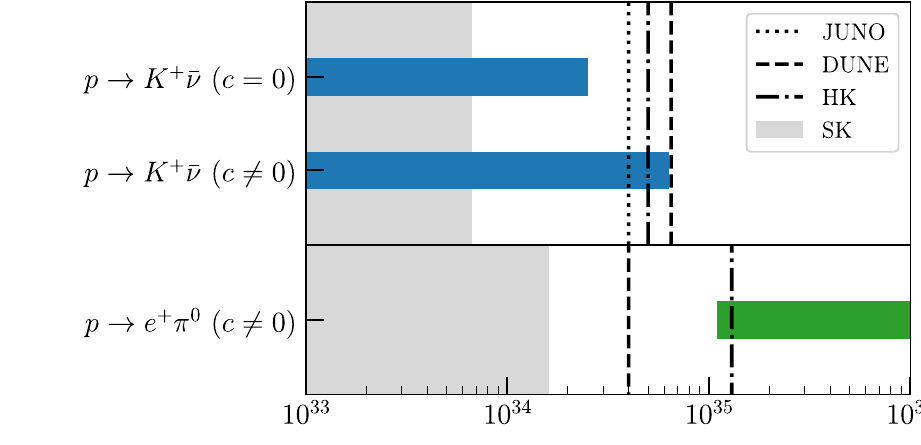
Fig. 16 The range of p → K + ν lifetimes found in the CMSSM (see Fig. 11) for the cases c = 0 and c (cid:15)= 0 (blue bands) compared with the sensitivities of the JUNO, Hyper-K and DUNE experiments. We also show results for p → π 0 e + in the CMSSM (see Fig. 17) with c (cid:15)= 0 (green band). The gray shaded areas are excluded by the Super-Kamiokande experiment